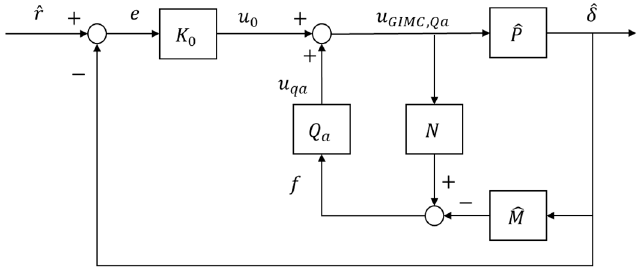
Figure 13. The improved GIMC control structure for the suspension system. For Figure 12,